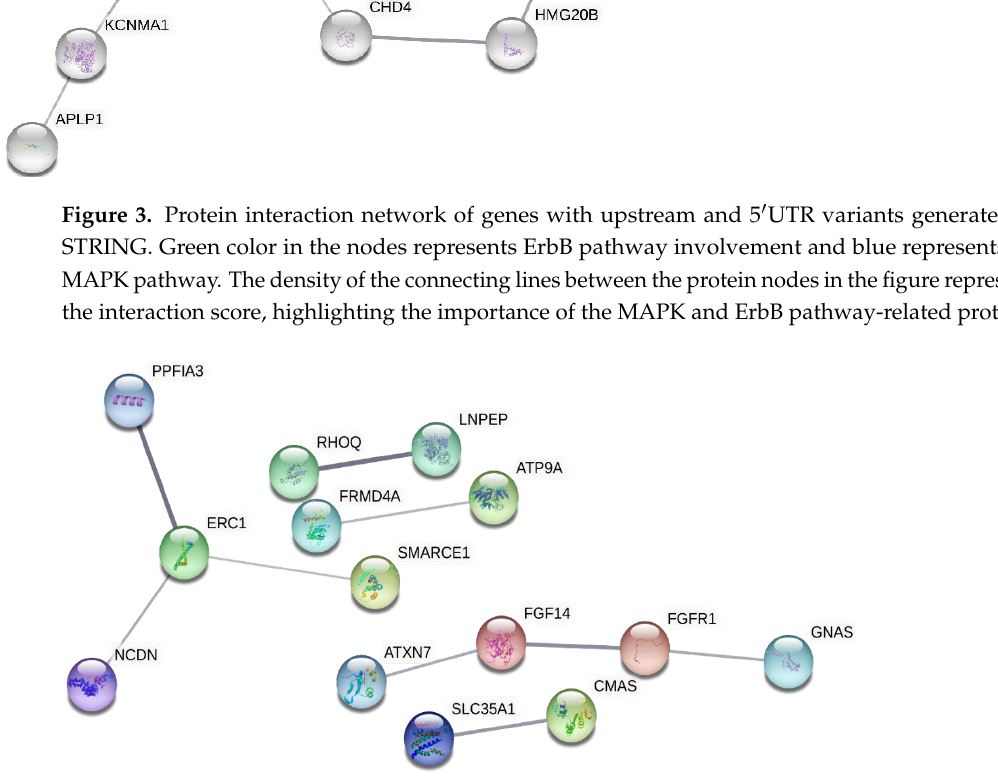
Figure 4. Protein interaction network of genes with 3′ UTR variants generated by STRING. No path- way enrichment was found here. Due to the lack of pathway detection, the color of the nodes was randomly selected by the software and serves only for differentiation purposes.